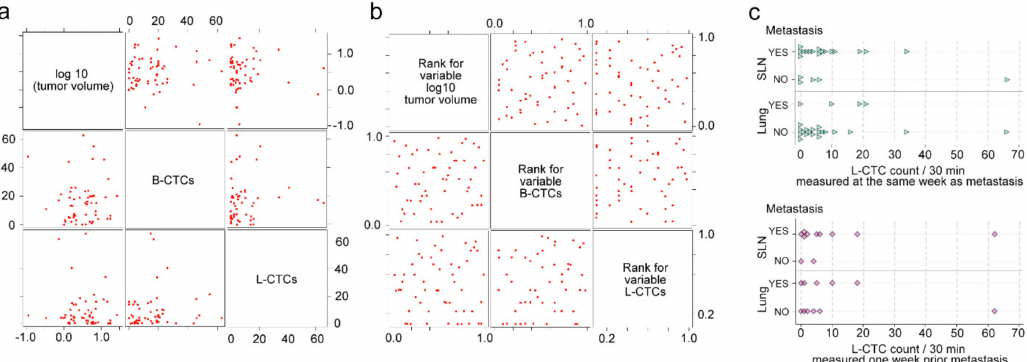
Figure7. Statisticalanalysis. ( a , b )ScatterplotmatricesofcorrelationbetweenL-CTCcount, B-CTCcount and primary tumor volume, n = 56 records. ( c ) Scatterplot matrices of correlation between L-CTCs and